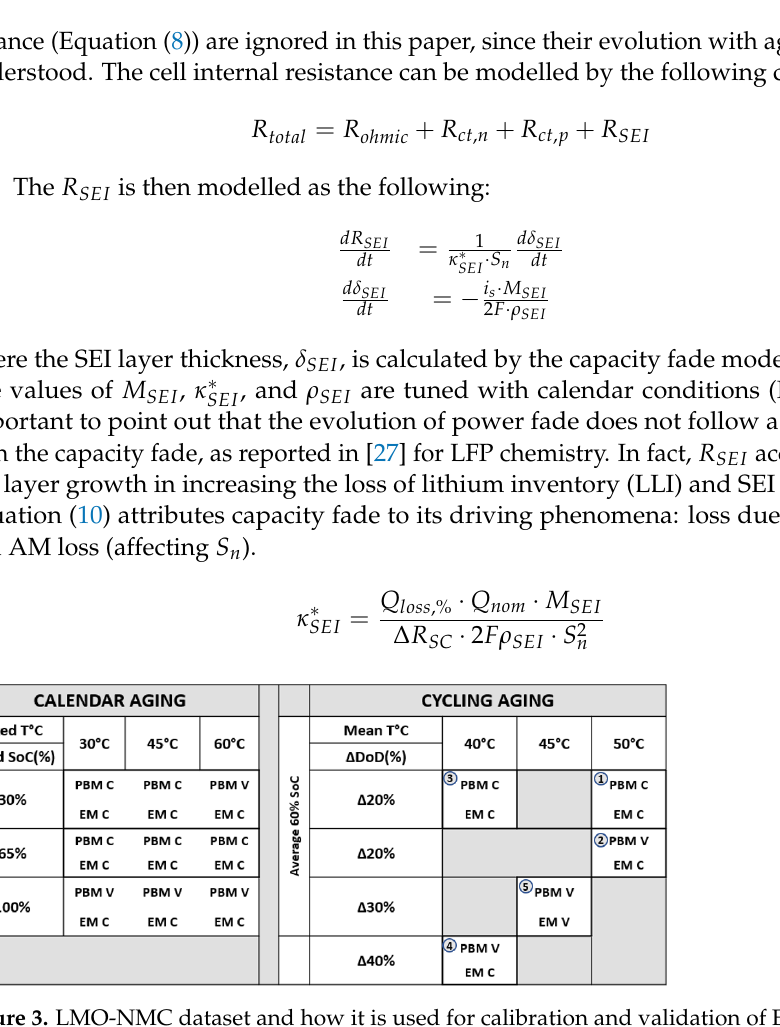
Figure 3. LMO-NMC dataset and how it is used for calibration and validation of EM and PBM. ‘C’ and ‘V’ represent the conditions used for calibration and validation, respectively. The numbers in the circle indicate the different power profiles used during the aging